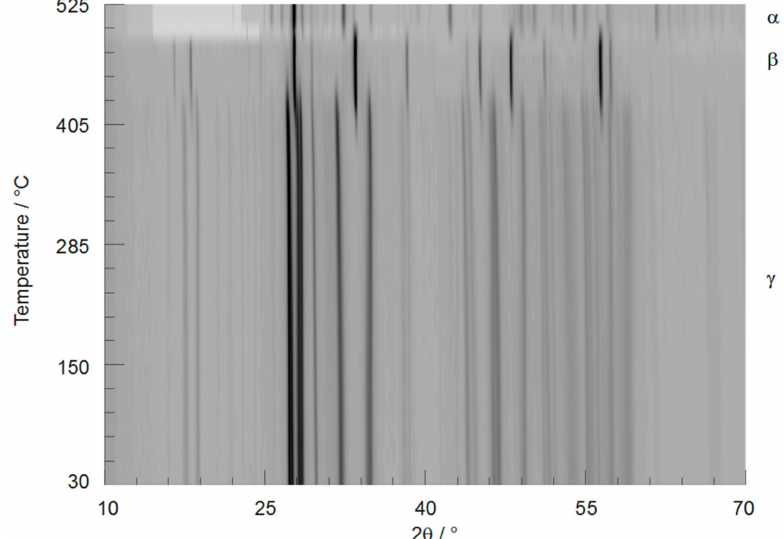
Figure 6. Temperature-dependent X-ray powder diffraction patterns of PbTeO 3 during heating in the range 30–525 ◦ C. Assigned phases are given on the right.